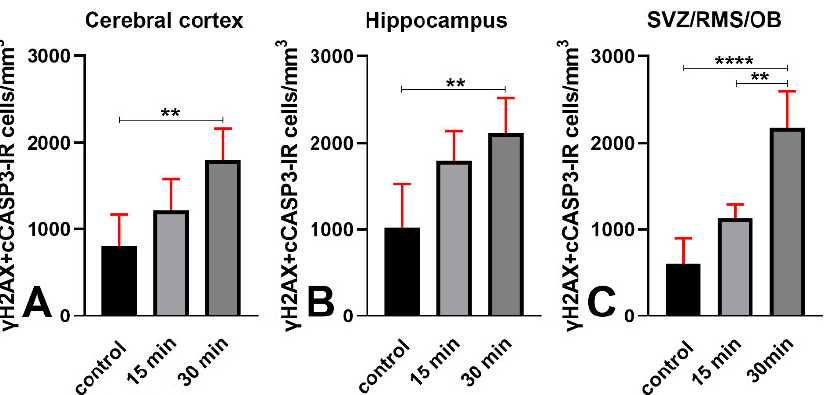
Figure 11. Effect of X-ray irradiation on the volumetric density of γ H2AX+cCASP3 immunoreactive cells in the cerebral cortex ( A ), hippocampus ( B ) and SVZ/RMS/OB ( C ). Staining for γ H2AX was carried out with the Abcam primary antibody. Data are expressed as mean ± 95% CI. ** 0.01 > p > 0.001, **** p < 0.0001. Bars are 95% CI. See Appendix H for numerical data of statistics.